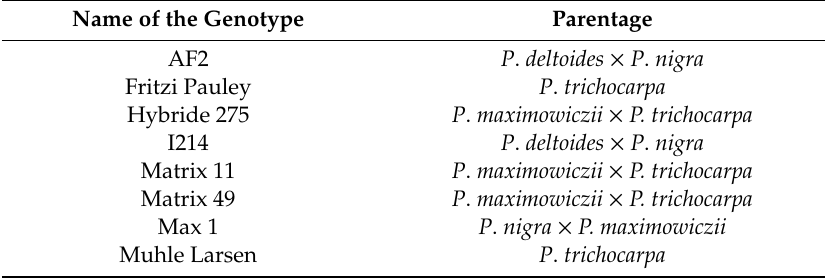
Table 1. Genotypes and their parentage used in the experiment ( n = 512 per genotype).